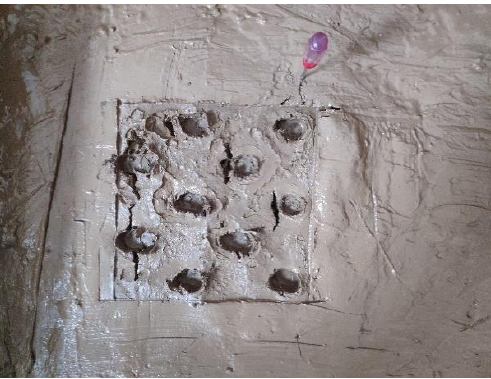
Figure 7. Test pictures.